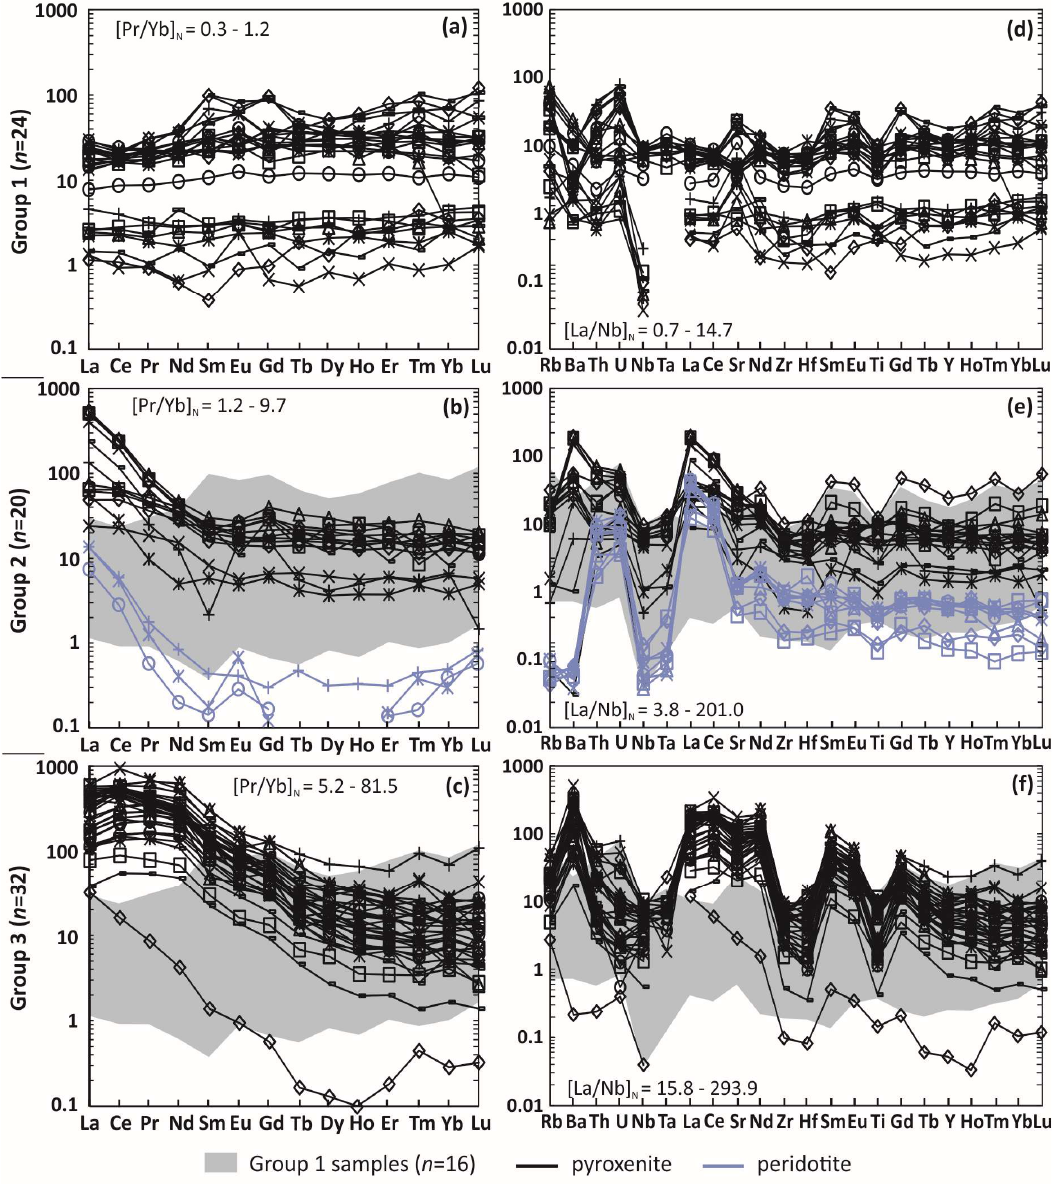
Figure 13. Chondrite-normalised REE ( a – c ) and primitive mantle-normalised [88] trace-element plots ( d – f ) for amphibole grains.